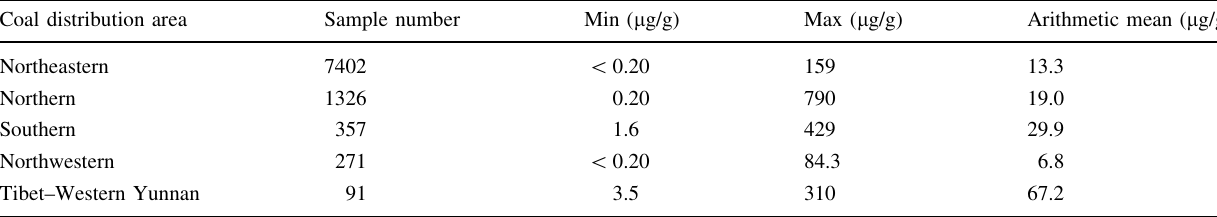
Table 6 Arithmetic means of lead contents in coals from different coal-bearing regions Coal distribution